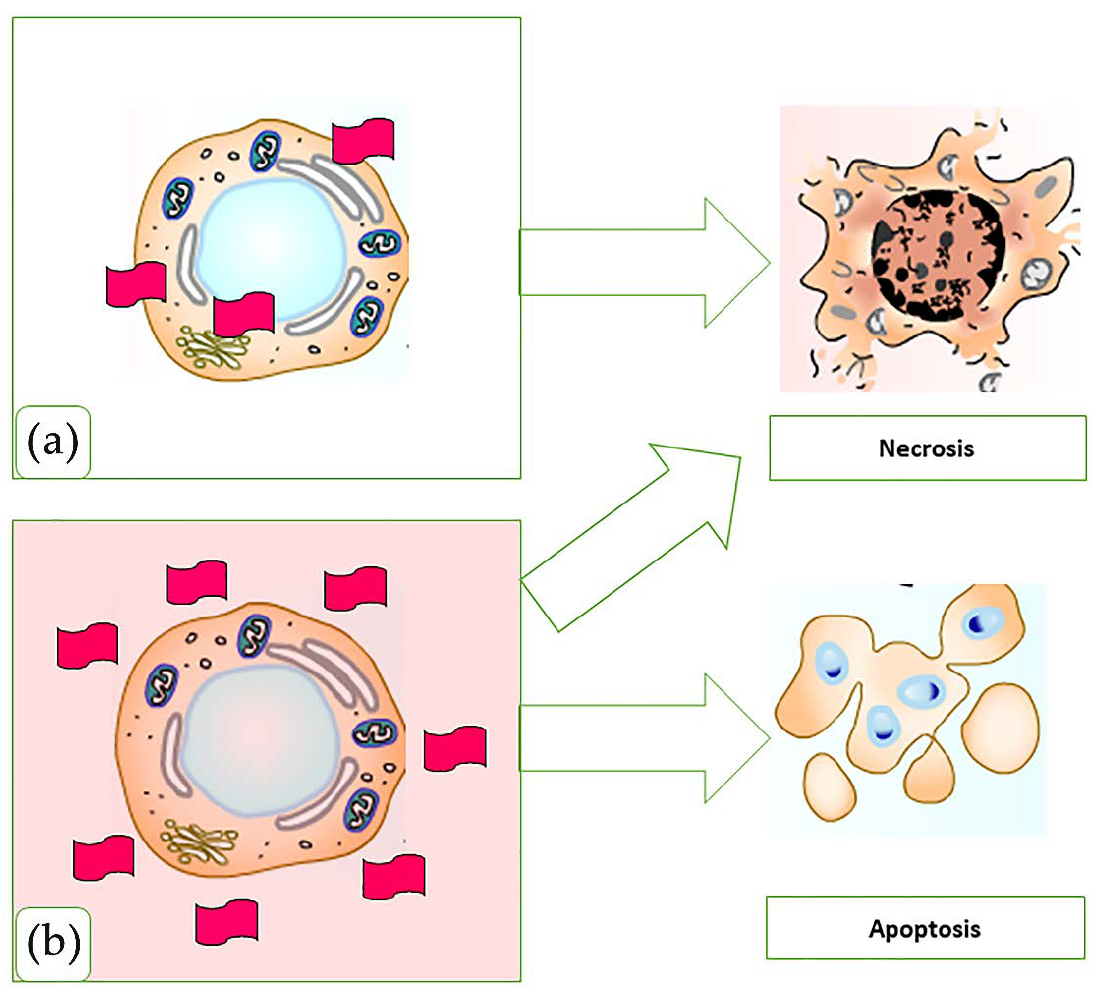
Figure 26. Proposed mechanisms of anticancer effects of MXenes (figure description provided in the main text).